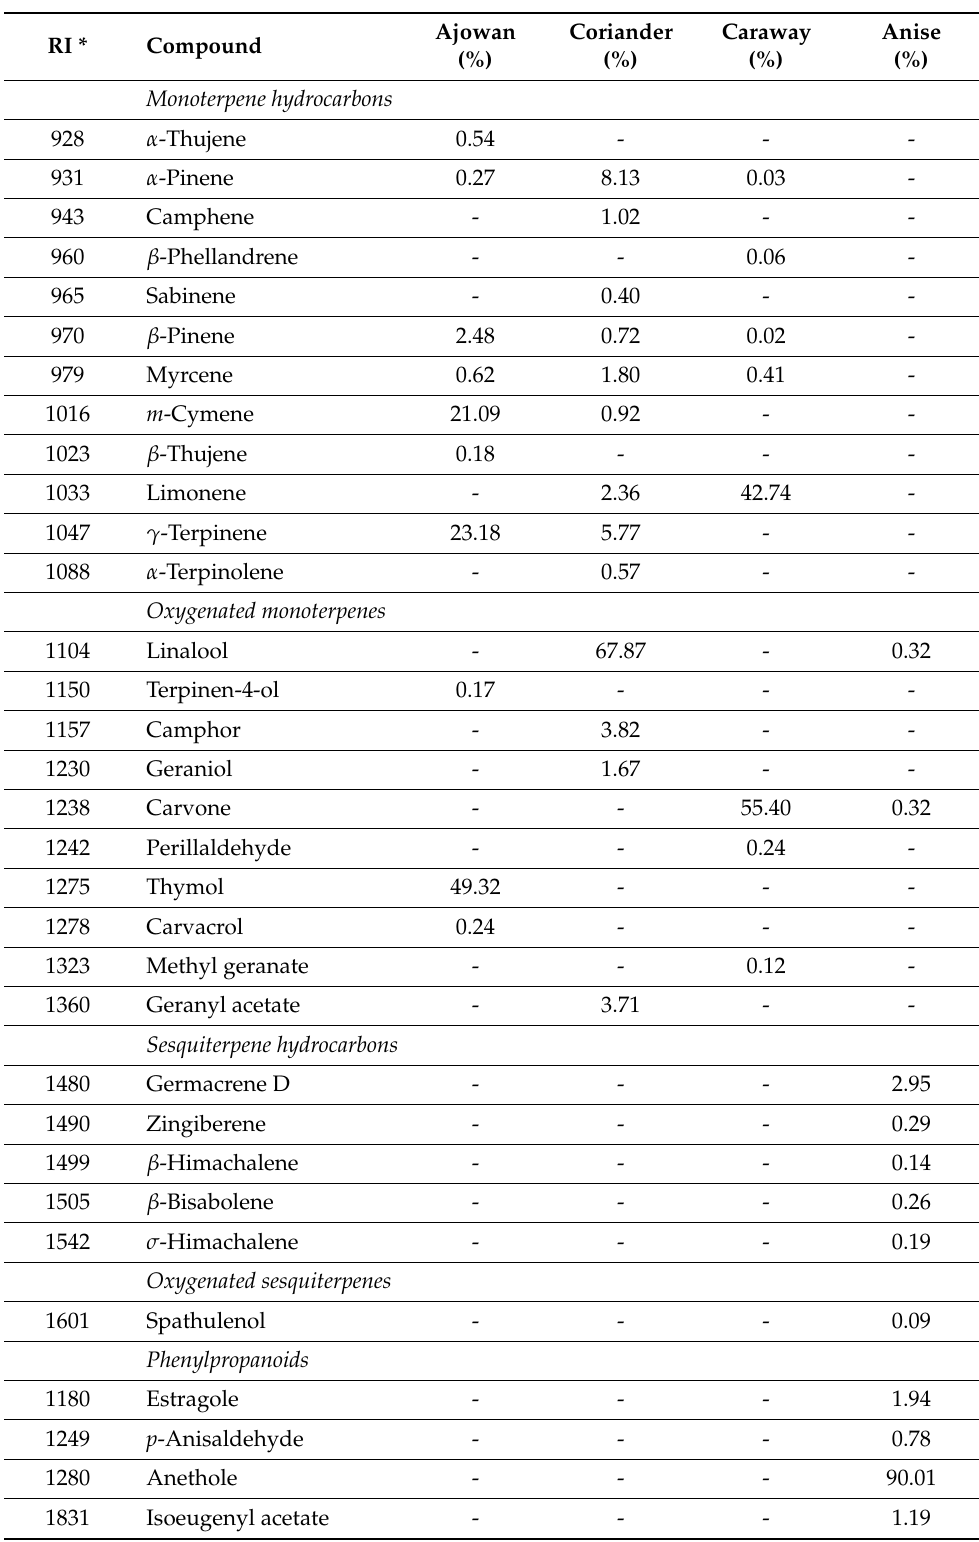
Table 1. Main constituents of essential oils isolated from Apiaceae